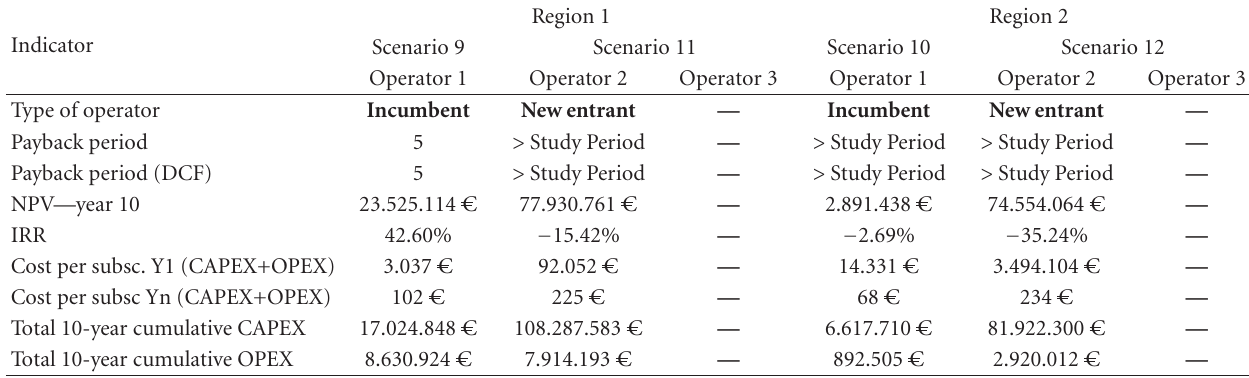
Table 13: General economic results of FTTH(PON) with infrastructure sharing.